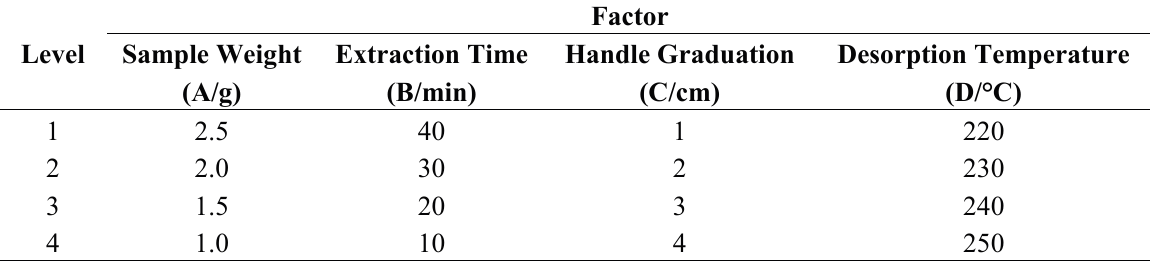
Table 4. L 16 (4 4 ) orthogonal test to optimized HS-SPME